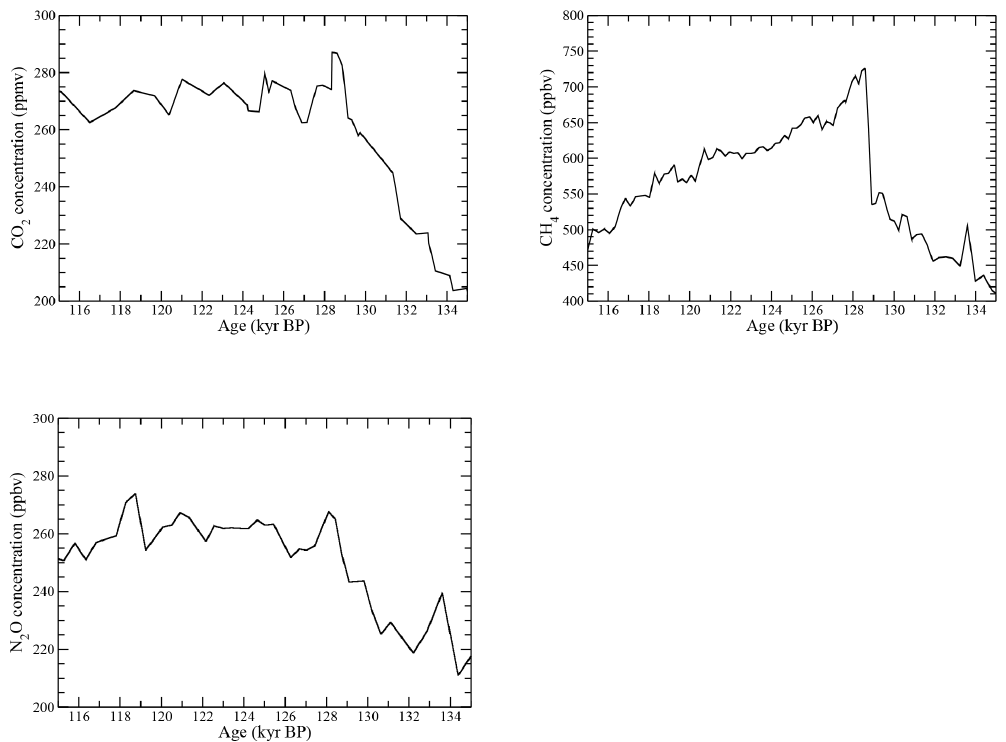
Figure 2. Evolution of the atmospheric concentration of several greenhouse gases as used in the transient simulations between 135kyrBP and 115kyr BP. (top left) CO 2 (Petit et al., 1999; Pépin et al., 2001; Raynaud et al., 2005); (top right) CH 4 (Loulergue et al., 2008); and (bottom left) N 2 O (Spahni et al., 2005).